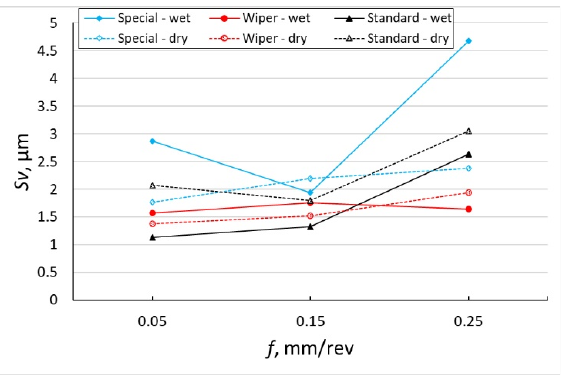
Figure 5. The impact of feed f on the variability of roughness parameter Sv .